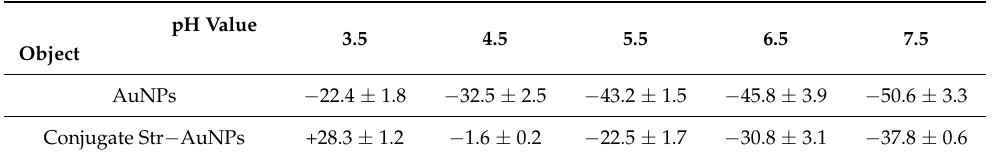
Table 1. ζ -potentials (mV) of suspensions of gold nanoparticles and gold nanoparticles in a conjugate with streptavidin at different